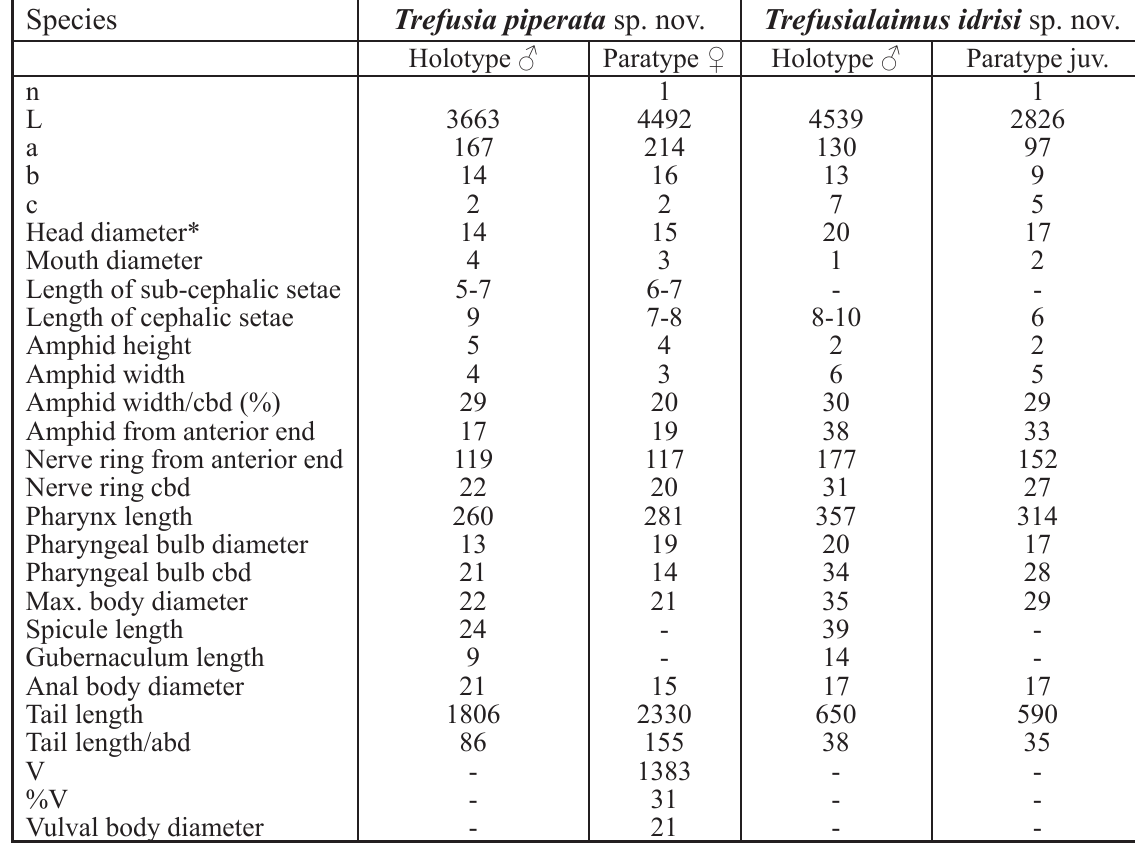
Table 1. Morphometrics (µm) of Trefusia piperata n. sp. and Trefusialaimus idrisi n. sp. (a: body length/ maximum body diameter, abd: anal body diameter, b: body length/pharynx length, c: body length/tail length, cbd: corresponding body diameter, V: vulva distance from anterior end of body, %V: V/total body